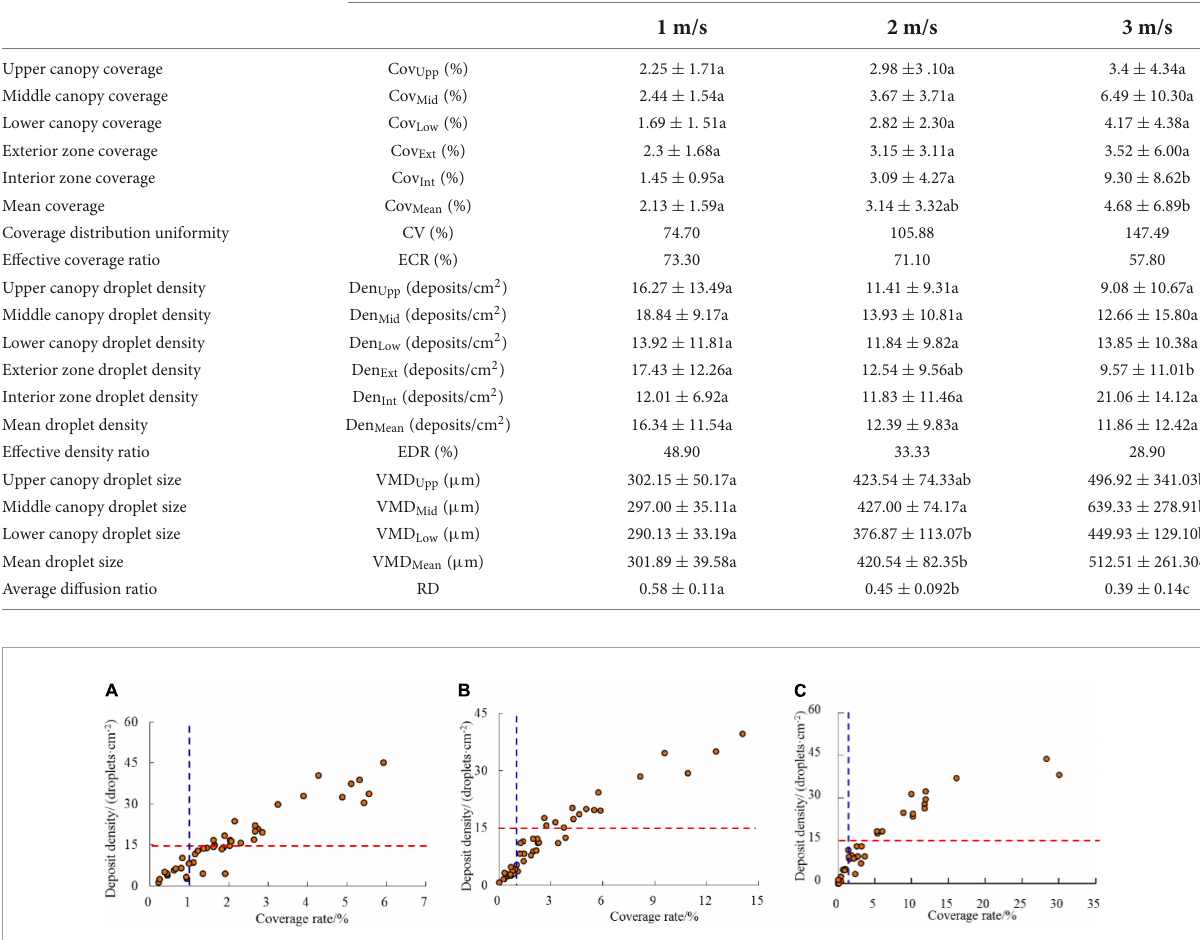
TABLE 2 Spray coverage characteristics in canopy for the different flight velocities.